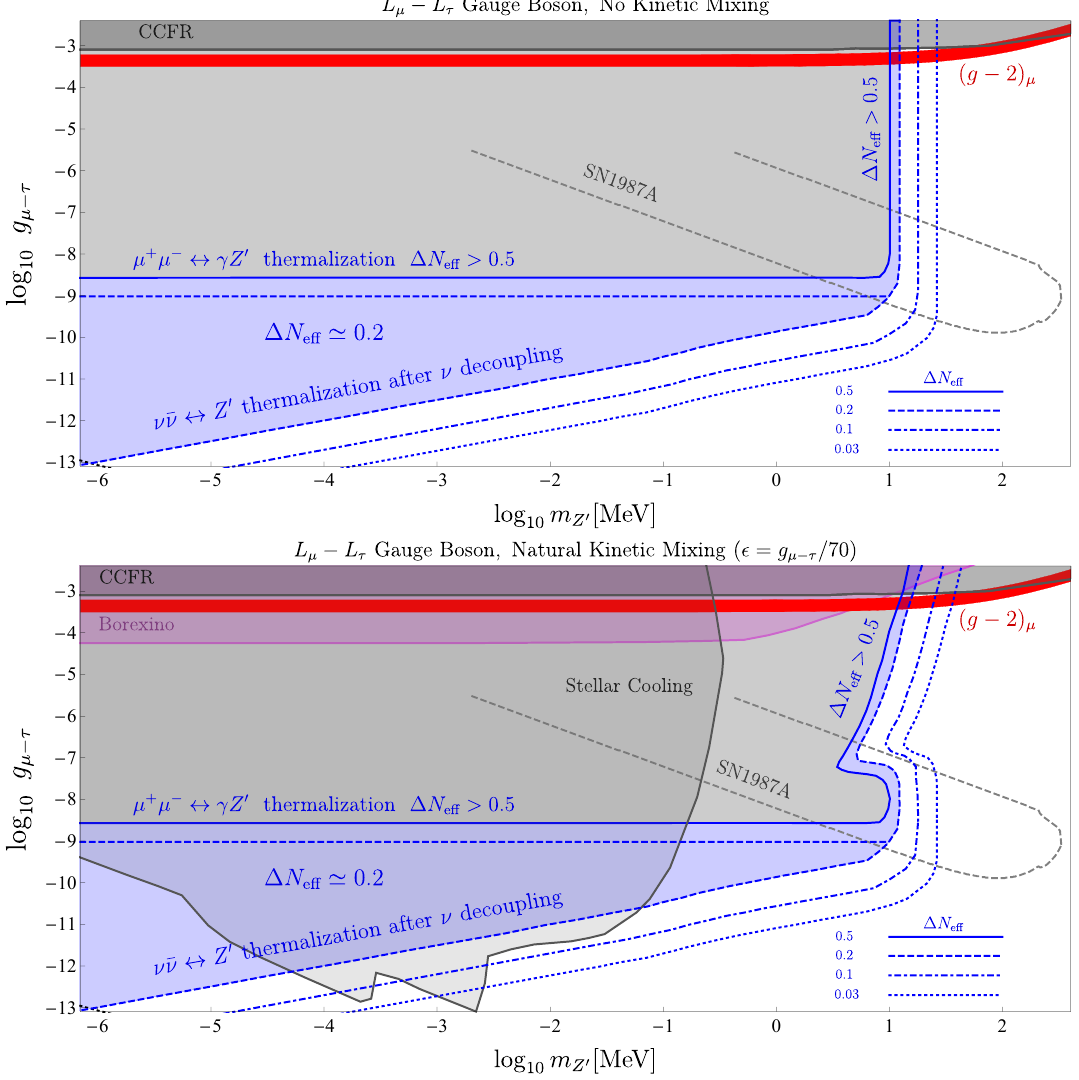
Figure 2 . A summary of the phenomenology of a L (cid:22) (cid:0) L (cid:28) gauge boson in the absence of kinetic mixing ( (cid:15) = 0) or assuming the \natural" degree of kinetic mixing associated with the diagrams shown in (cid:12)gure 1 ( (cid:15) ’ g (cid:22) (cid:0) (cid:28) = 70). We show contours of constant (cid:1) N e(cid:11) , as well as the regions favored by measurements of the muon’s anomalous magnetic moment, ( g (cid:0) 2) (cid:22) (red band). We also identify the regions that are excluded by measurements of di-muon production in neutrino nucleus scattering (CCFR) [5, 40], solar neutrino observations (Borexino) [24, 41, 42], by stellar cooling [43, 44] and by observations of Supernova 1987A [45] (see section 4 and appendix B). Regions shaded in blue yield (cid:1) N e(cid:11) = 0 : 2 (cid:0) 0 : 5 which can substantially ameliorate the tension between early and late time measurements of H 0 .